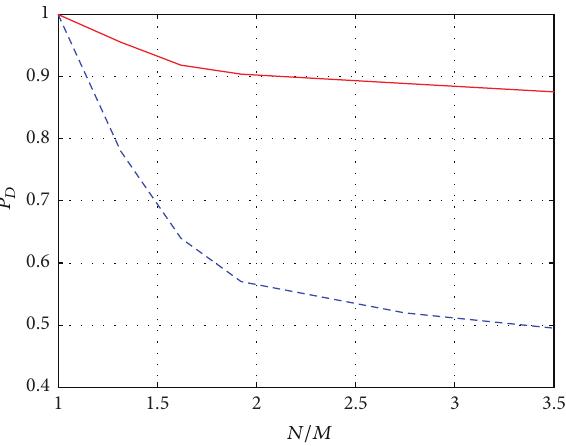
Figure 4: 𝑃 𝐷 versus 𝑁/𝑀 for SequOMP detector (blue dashed line) and Sup-GLRT detector (red solid line), in the case of two scatterers of different amplitude with 3 dB SNR difference (SNR 1 = 8 dB and SNR 2 = 5 dB), at a separation distance 𝐷 𝑠 = 2𝜌 𝑠 and for 𝑃